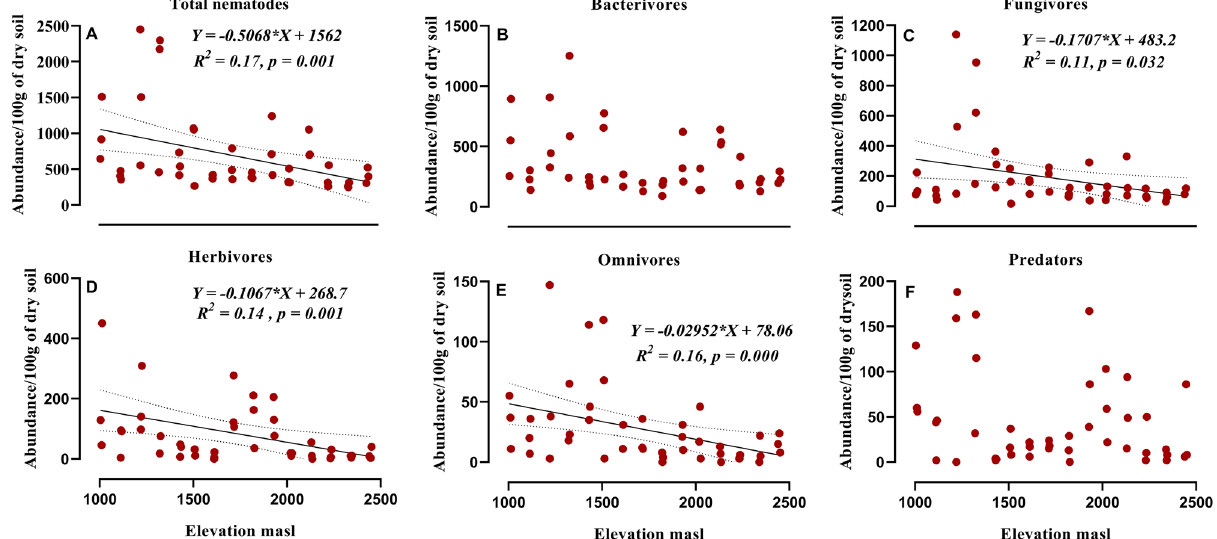
Figure 2. Relationship between elevation and total abundance of nematodes ( A ), trophic groups: Bacterivores ( B ), Fungivores ( C ), Herbivores ( D ), Omnivore ( E ), Predators ( F ). Equation for Y , R 2 (coefficient of determination), p (significance) of linear regression and regression line and dotted lines of 95% of confidence interval are shown only for significant